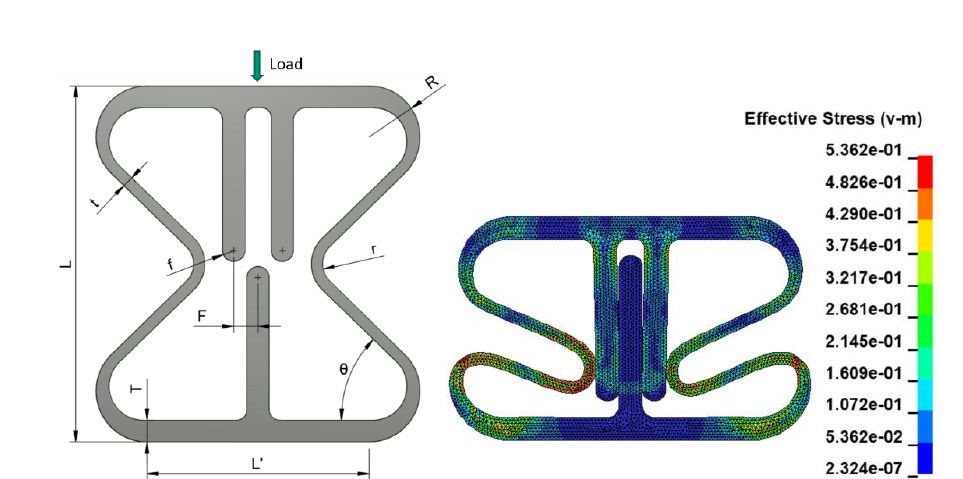
Fig. 1. A bowtie unit cell equipped with friction element in its original state. The key geometrical parameters shown are to be optimized for maximum energy dissipation via friction under compressive loading (a). A simulation output image with colour fringing of von-Mises stress [GPa] under compressive load (b). The optimal set of geometrical parameters aid to efficiently exploit the frictional properties that paves a way for strain rate dependency in the